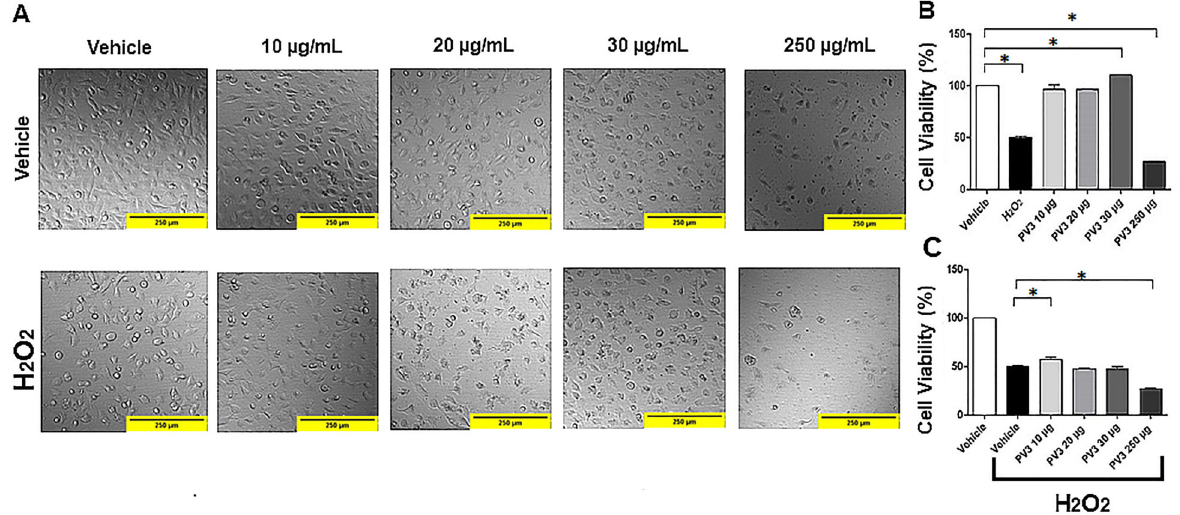
Figure 1. A , Qualitative comparison of Phaseolus vulgaris peptide (PV3) treatments at different concentrations in pre-stress and post- oxidative stress by 3% (v/v) H 2 O 2 for 1 h (100 (cid:1) magni fi cation, scale bar 250 m m, Nomarski interference contrast microscopy). B , Evaluation of PV3 cytotoxicity at different concentrations in human endothelial cells by MTT assay. C , Evaluation of the cytoprotective potential of PV3 pretreatment against oxidative stress caused by 3% H 2 O 2 in MTT assay. The data are reported as means ± SE. *P o 0.05 (ANOVA and Fisher test).